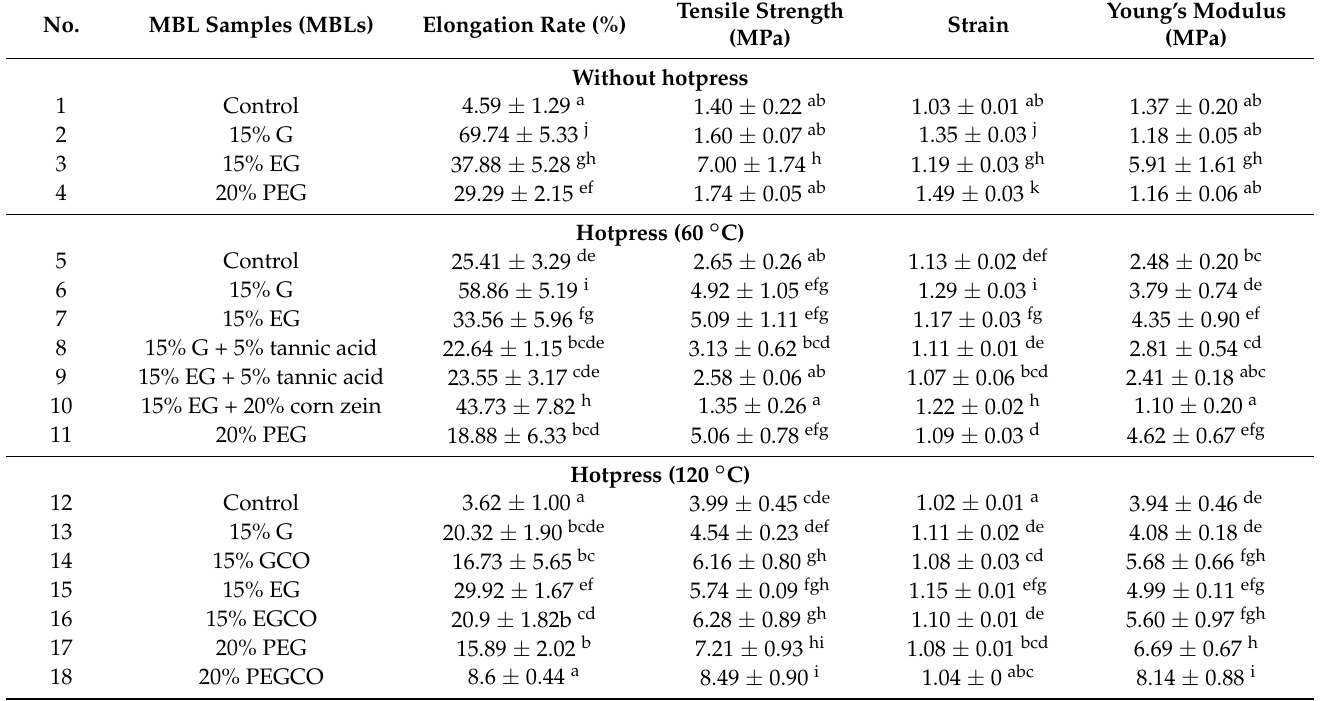
Table 2. Mechanical properties of MBL from F. fraxinea (G—glycerol, EG—ethylene glycol, PEG— polyethylene glycol (GCO, EGCO, and PEGCO with ‘CO’ denoting cheesecloth-over-layered MBLs). Each value represents the mean ( ± SD), and species with the same letter do not differ significantly by the Duncan test ( p < 0.05). MBLs—Mycelium-Based Leather Samples; MPa—Mega Pascal; %— percentage, ◦ C—degree